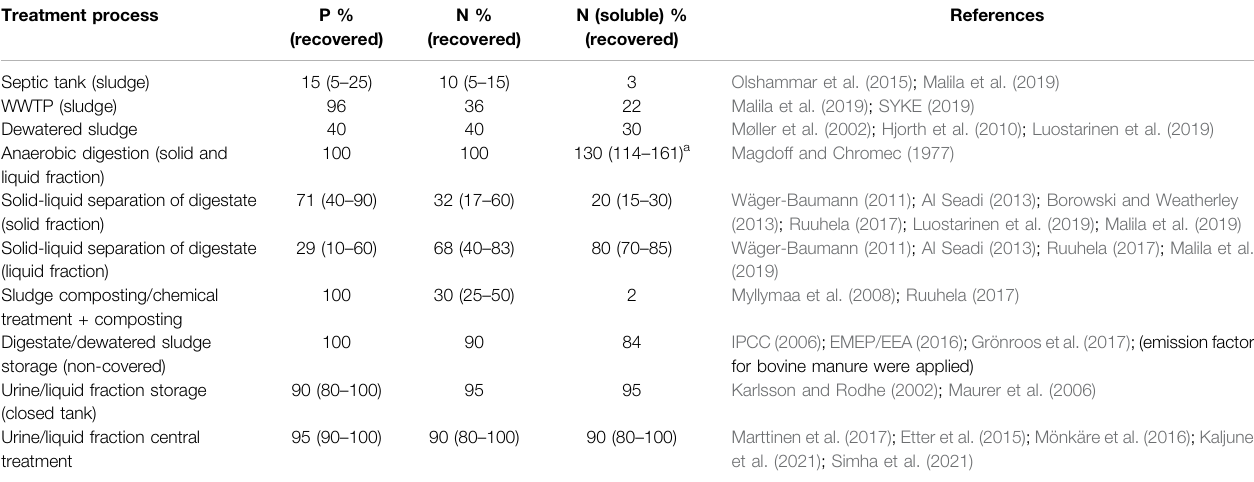
TABLE 3 | Phosphorus, nitrogen and ammonium nitrogen (in percentages) recovered from the input material of different treatment processes. Variation range is shown in